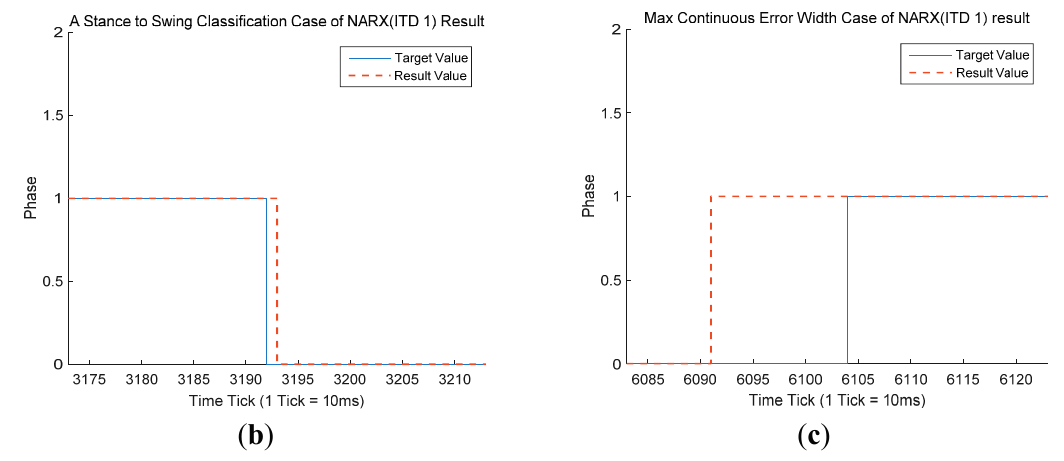
Figure 6. ( a ) Comparison of NARX results with an input time delay of 1 and the target values for frames 1500–3000. The blue line denotes the target value acquired by the force plates. The orange dotted line denotes the classification result of the NARX with ITD 1 classifier, the best NARX-based classifier; ( b ) General stance to swing classification for the NARX classifier in ( a ); ( c ) Max continuous error width for the NARX classifier in ( a ).